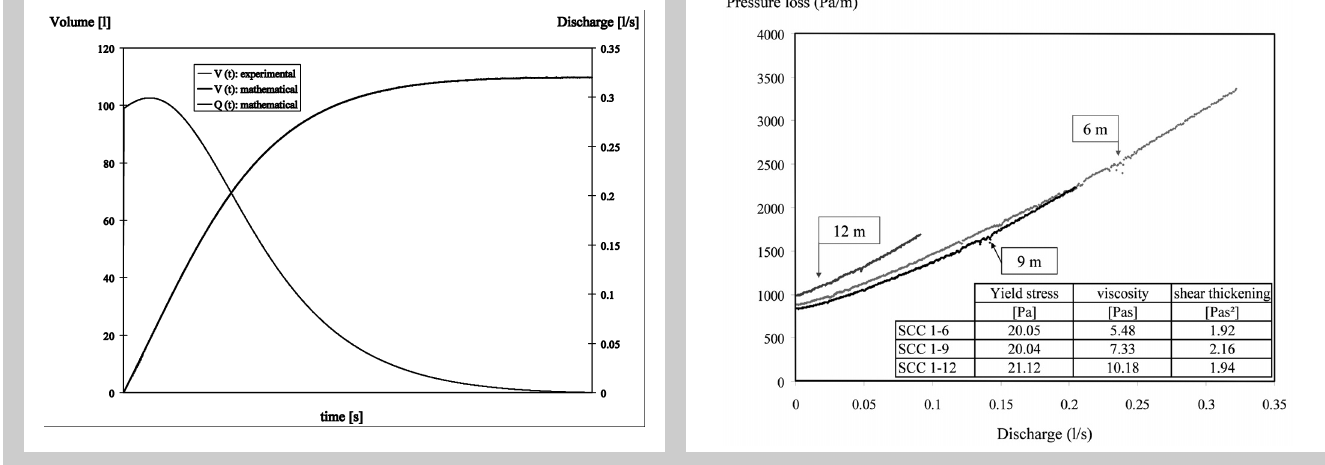
Figure 5 (left): Approximated volume vari- ation (grey) and discharge variation (black) with time. The peak in the Q(t) curve is most probably caused by thixotropy. Figure 6: Flow-test results for SCC type 1 with a concrete age of 60 minutes, performed at pipe lengths of 6, 9 and 12 m. If the rheological proper- ties are (almost) equal, the pressure losses, divided by the length of the pipe (almost)